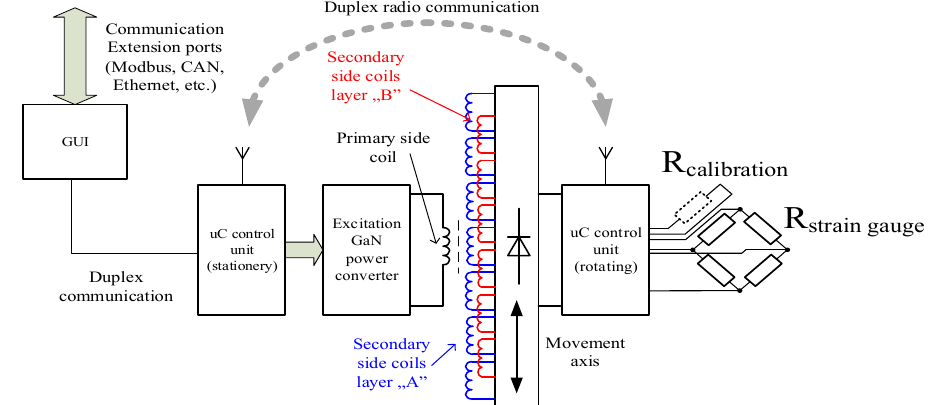
Figure 1. Overall system construction of a proposed, real time shaft power telemetry unit.